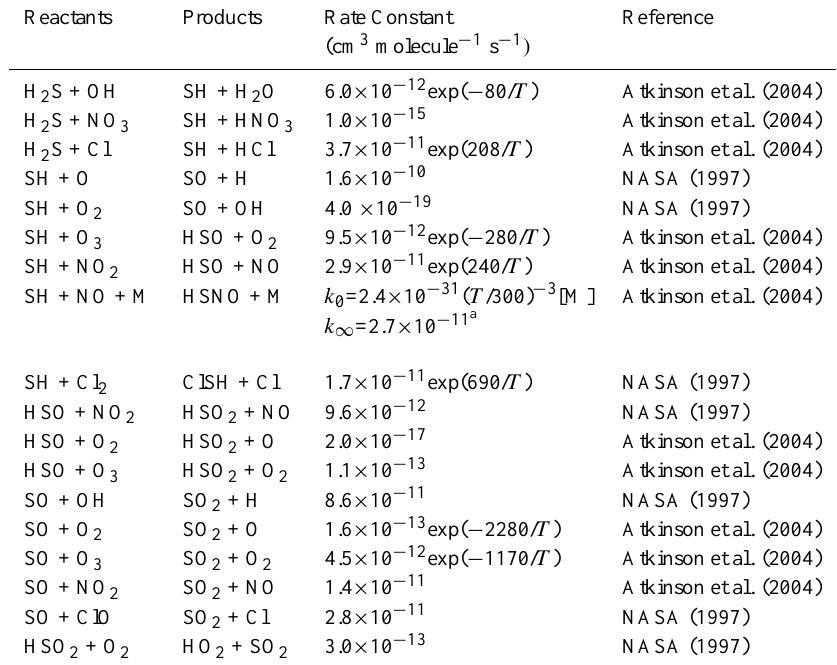
Table 2. Reactions added to CB05 for inorganic sulfur species and their reaction